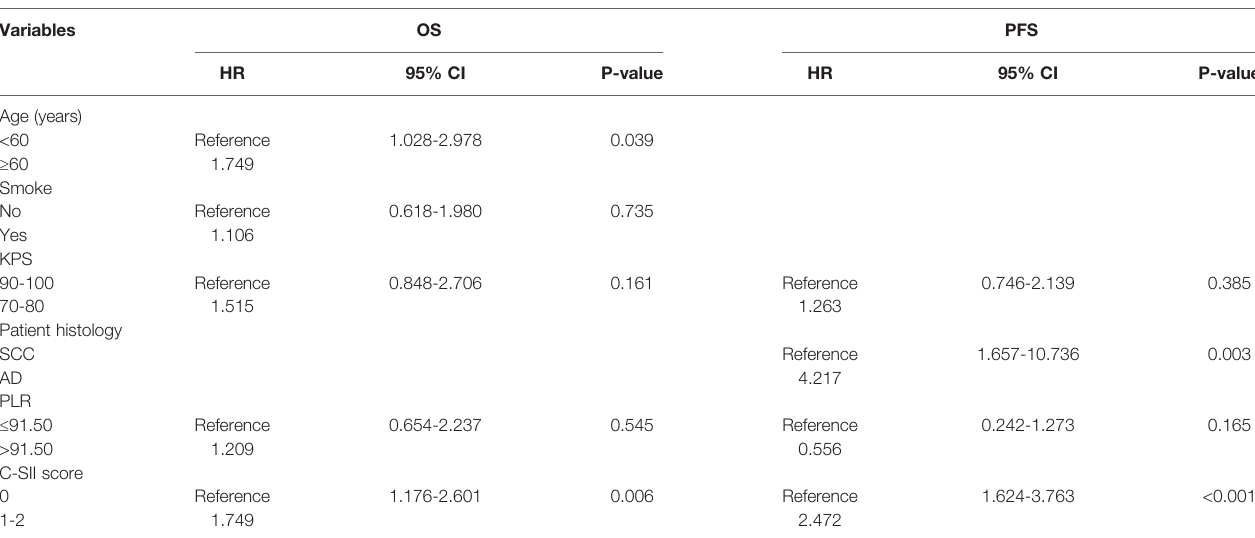
TABLE 5 | Multivariate Cox regression analysis of OS and